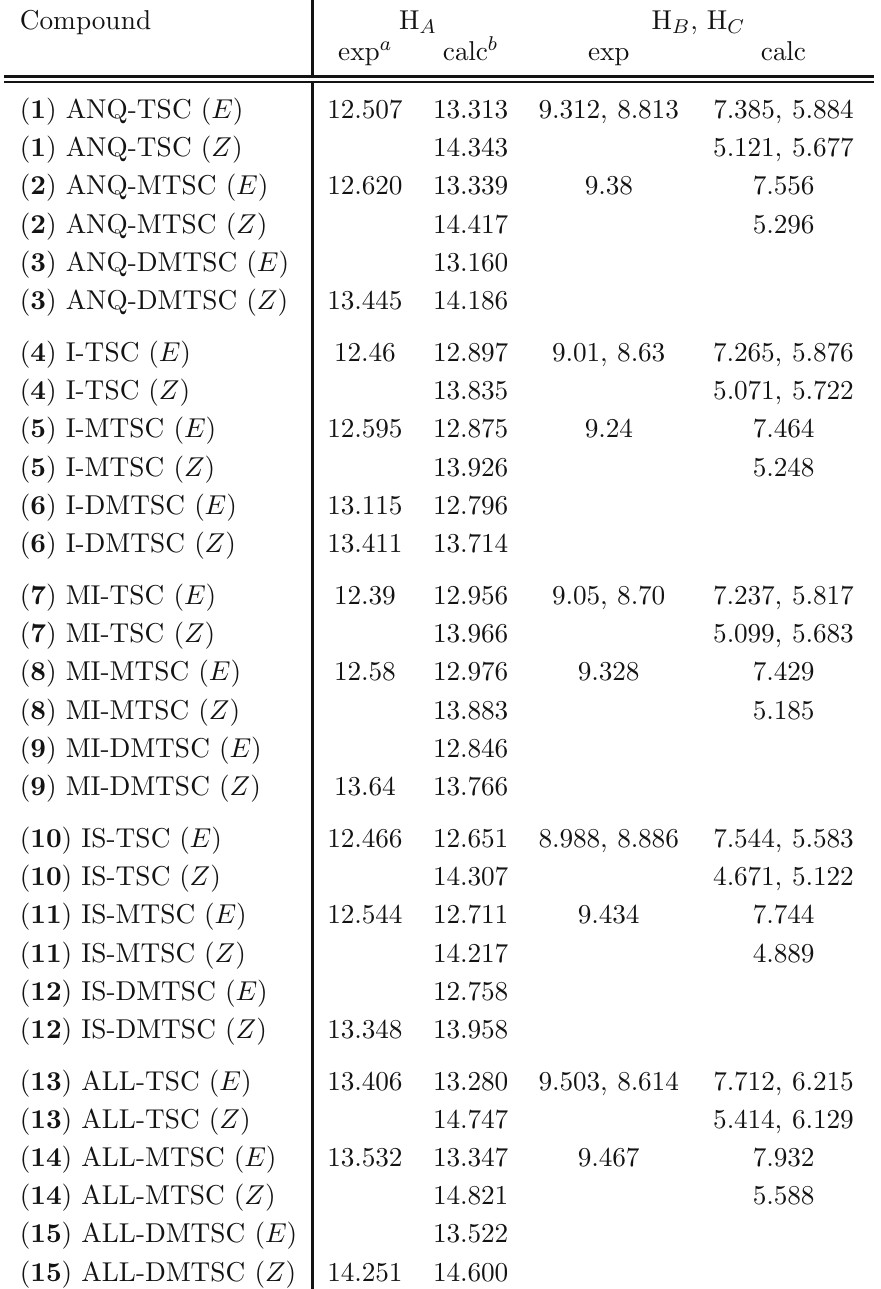
Table 3 Experimental and calculated 1 H NMR chemical shifts (ppm)